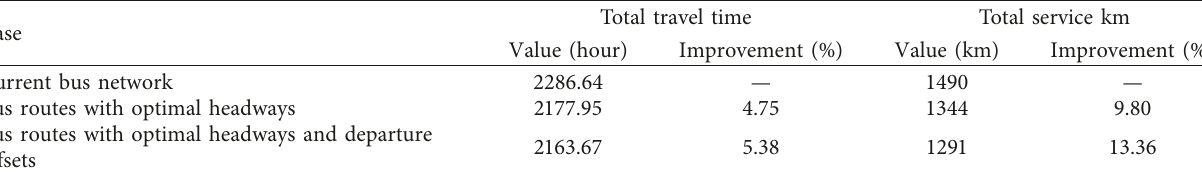
Figure 6: Convergence history of the proposed model with headway and offset variables. Table 4: Computational results in comparison with the current bus network of Çorlu.